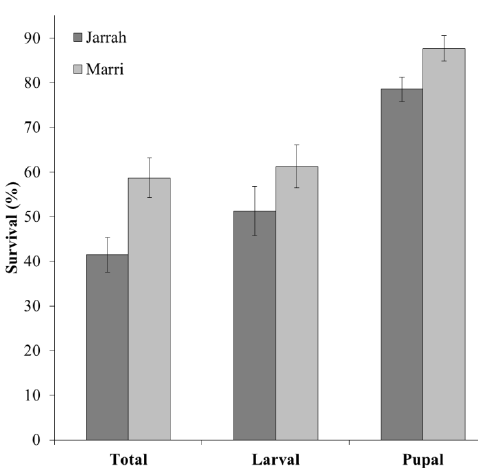
Figure 5. Percent survival of the Australian eucalyptus longhorned borer Phoracantha semipunctata for jarrah and marri trees, showing mean ( ± SEM) total survival (neonate larvae to emerged borers), larval survival (from neonates to pupation) and pupal survival (larvae that reached pupation to emerged borers) ( n = 35, 37, 34, 36, 34 and 36 trees, left to right).